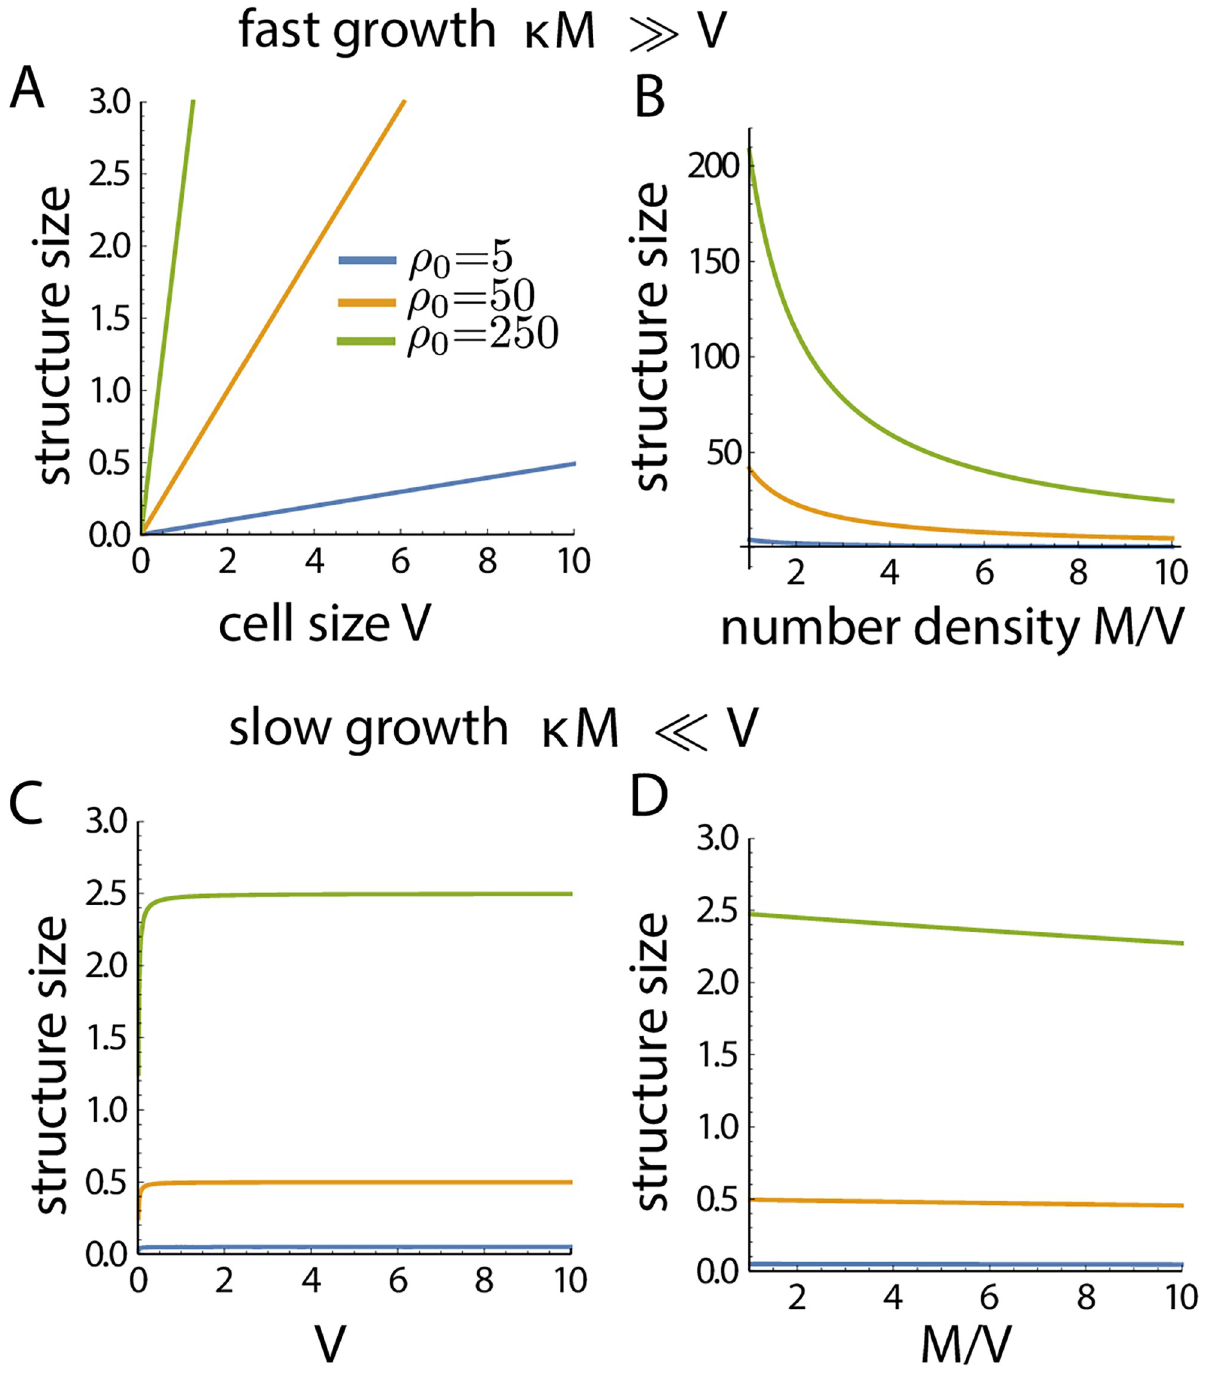
Fig 8. Structure size scaling with system size. The size-dependent growth model (with α = 0, β = 1) exhibits a regime where structure size does not scale with cell/system size ( V ) or the number of assembled structures, M . Growth rate of the structures can be tuned to achieve scaling of structure size with cell size. (A-B) shows the regime of structure size scaling with cell size, whereas (C-D) shows the regime no size scaling.